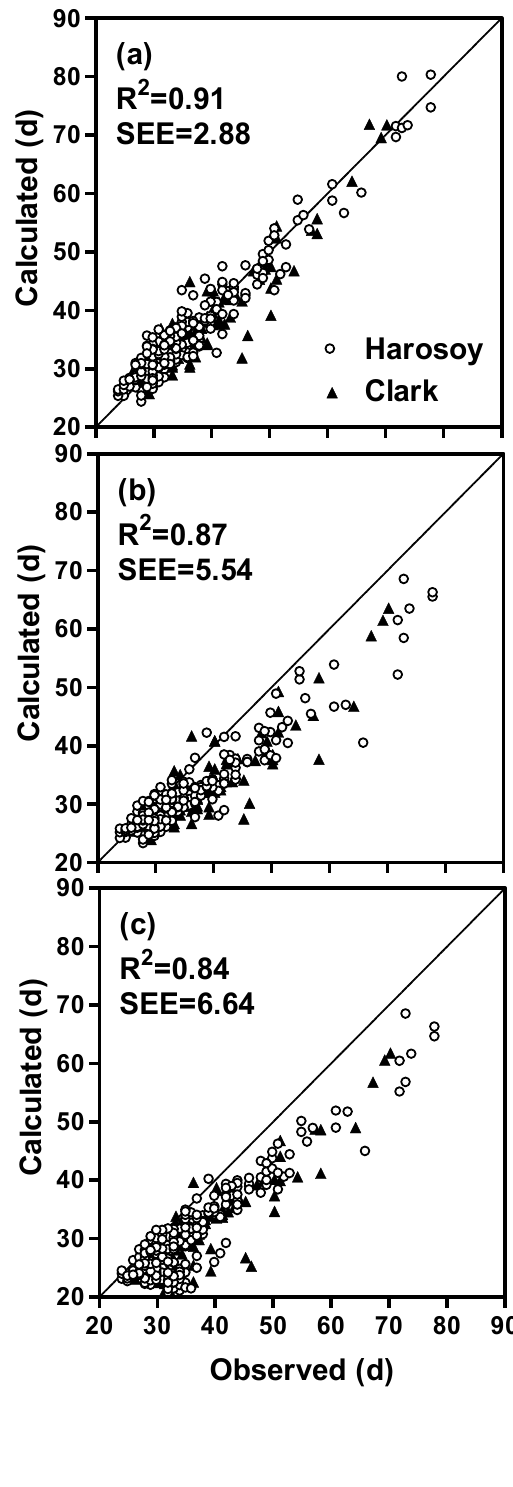
Figure 10. A comparison of calculated and observed days from planting to first flower for Harosoy and Clark soybean isolines for ( a ) the complete additive model, ( b ) the complete model without the rate of photoperiod change ( c ) the complete model without the irradiance